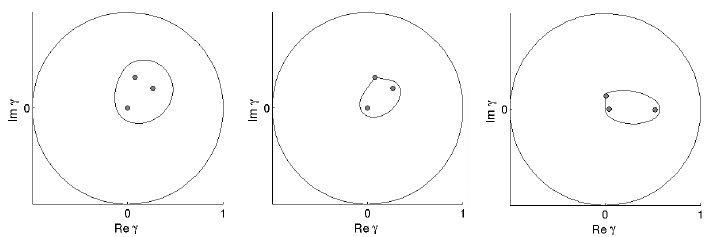
Figure 2. Examples of three types of coherence shape: ovular shape, union of ellipse and one point, ovular shape with flat